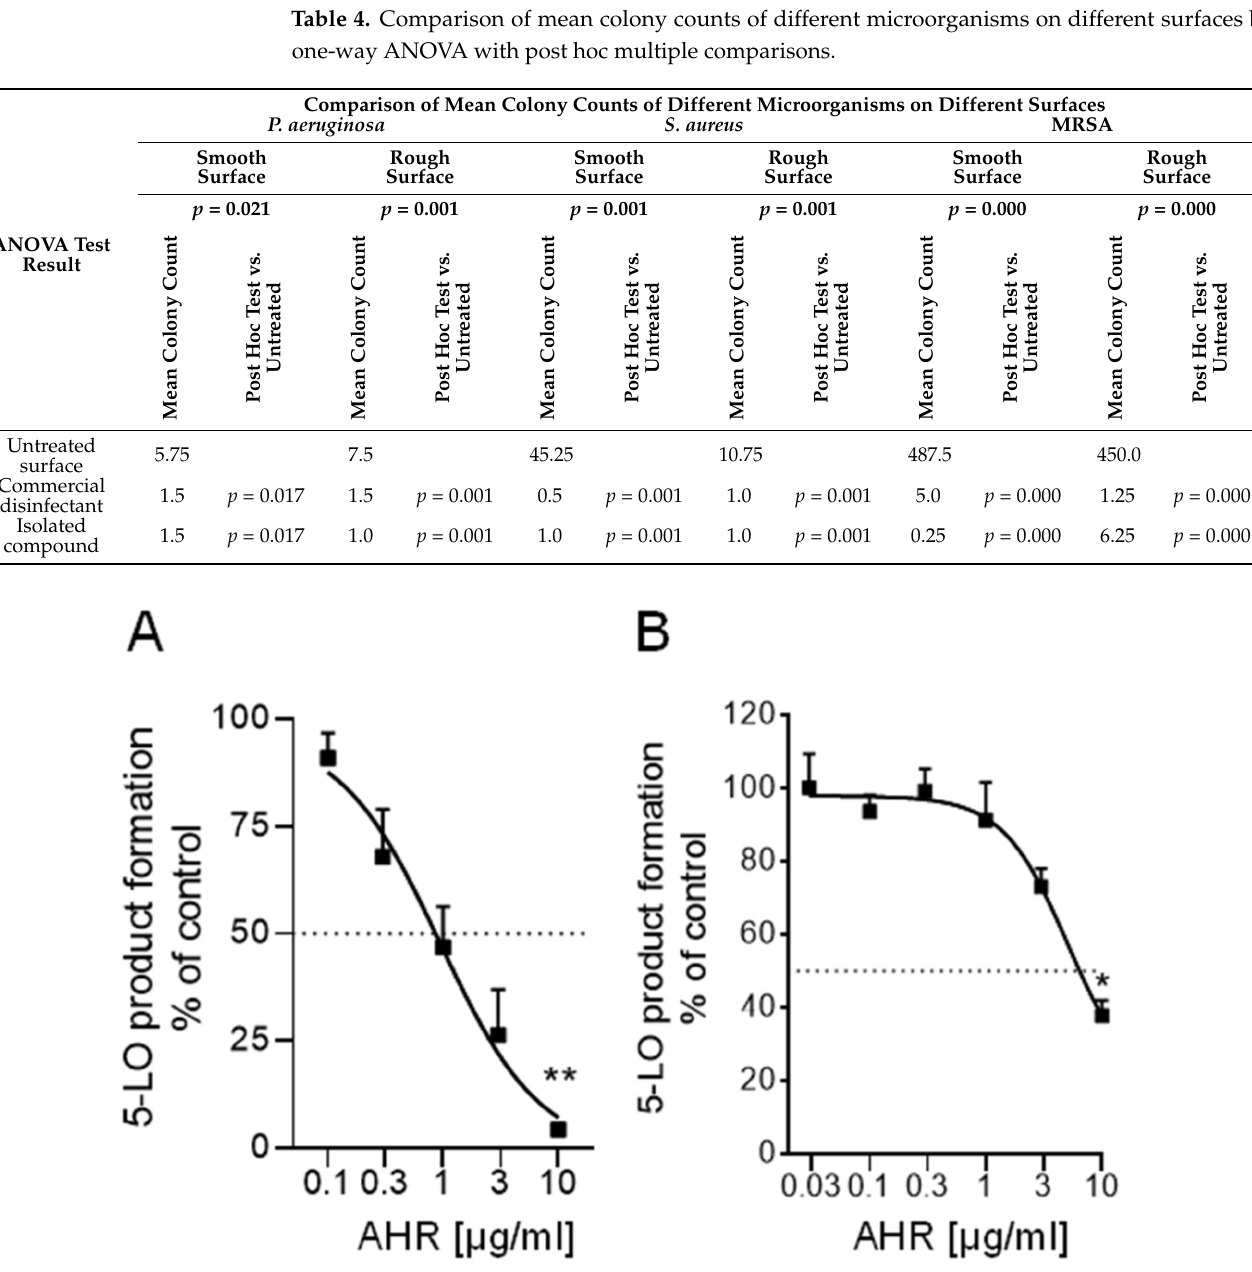
Figure 4. Inhibition of 5-LO by 7 α -acetoxy-6 β -hydroxyroyleanone (AHR) in ( A ) a cell-free assay and ( B ) in intact human neutrophils. Data are given as mean ± S.E.M, n = 4. Statistical evaluation of the data was performed by one-way ANOVA, * p < 0.05, ** p <